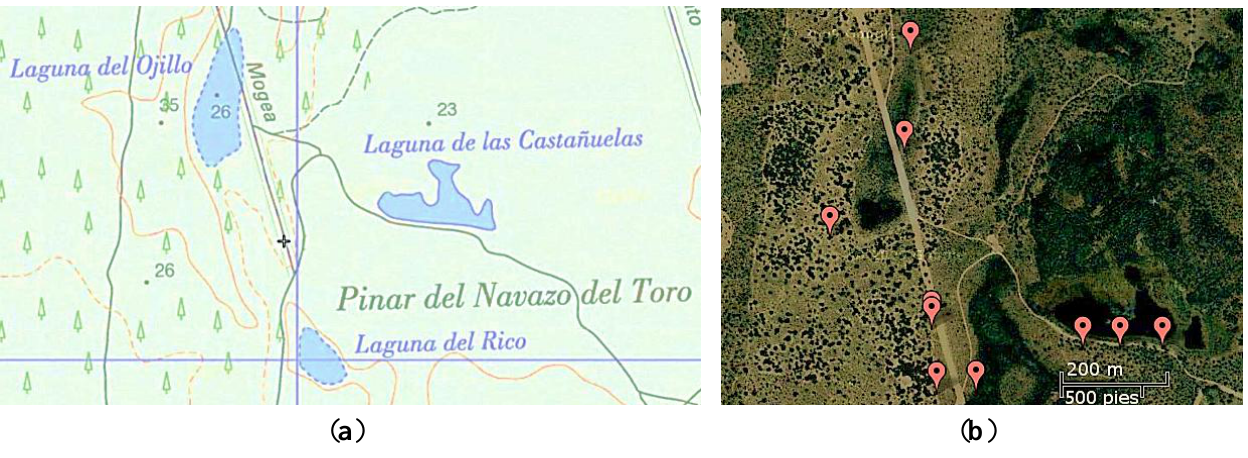
Figure 6. Localization of the ICARO 1 network. ( a ) satellite image, ( b ) topographical